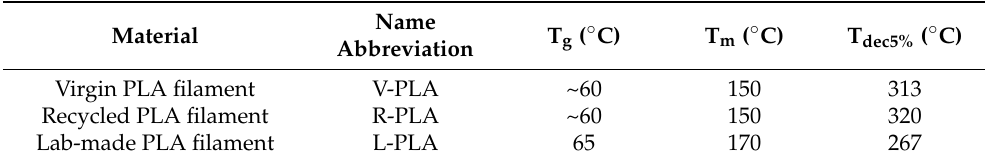
Table 1. Thermal properties of three filaments: melting temperature (Tm), glass transition tempera- ture (Tg), and initial decomposition temperature (Tdec5%) in correspondence of 5% in mass loss. Material